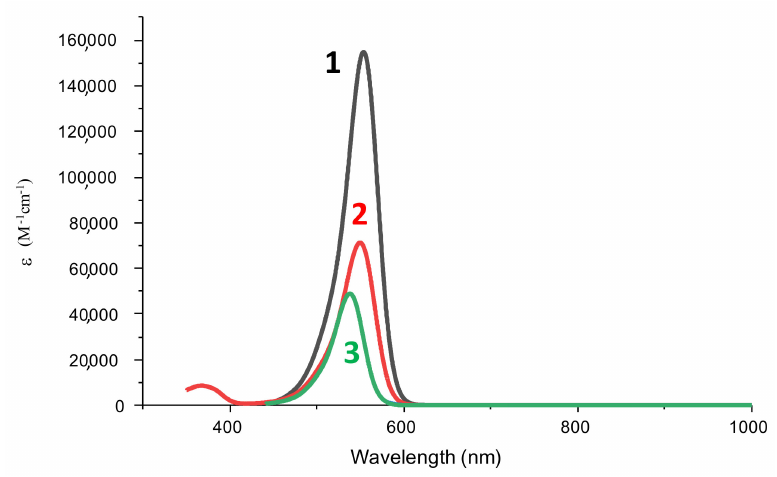
Figure 6. UV-vis absorption spectra of DASA12 (1); DASA11 (2) and DASA9 (3) in acetonitrile.